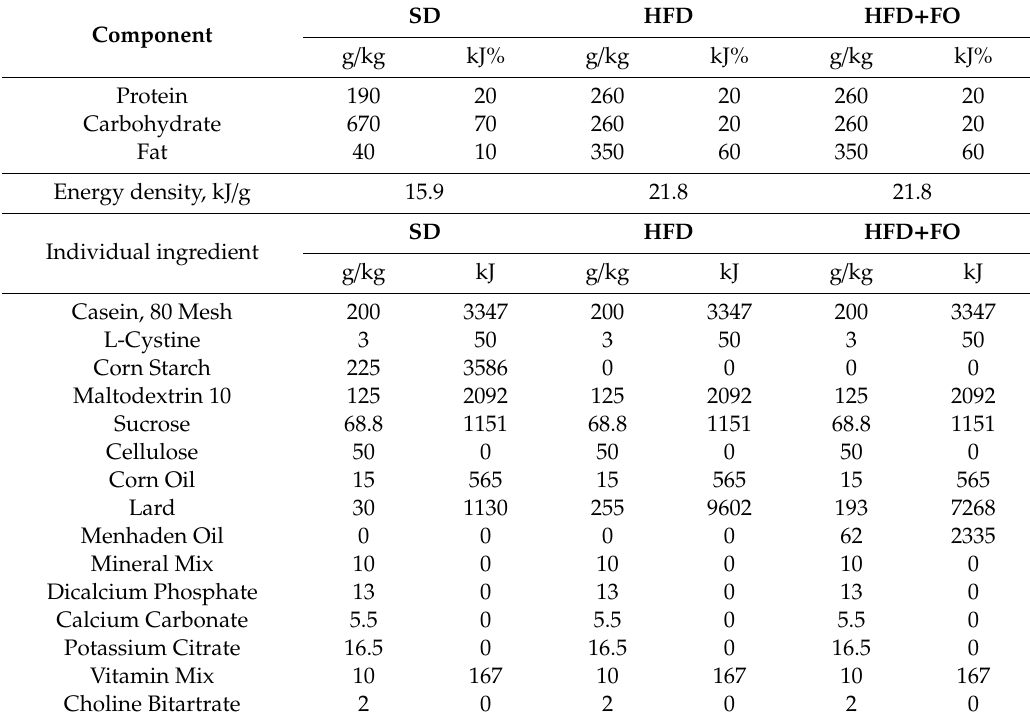
Table 1. Composition of purified experimental diets. Table lists the overall content (g / kg) and the percentage of total energy (kJ%) supplied from proteins, carbohydrates, and fats, and energy density of experimental diets (kJ / g), together with the content (g / kg) and caloricity (kJ) of individual ingredients. SD HFD HFD + Component